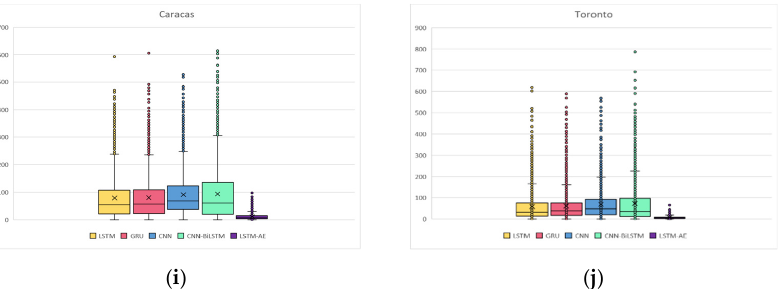
Figure 30. Boxplot of GHI forecasting error of 5 models for 5 models for: ( a ) Al-Baha; ( b ) Al-Jouf; ( c ) Al-Khafji; ( d ) Arar; ( e ) Hail; ( f ) Tabuk; ( g ) Taif; ( h ) Wadi-Addwasir; ( i ) Caracas; ( j ) Toronto.